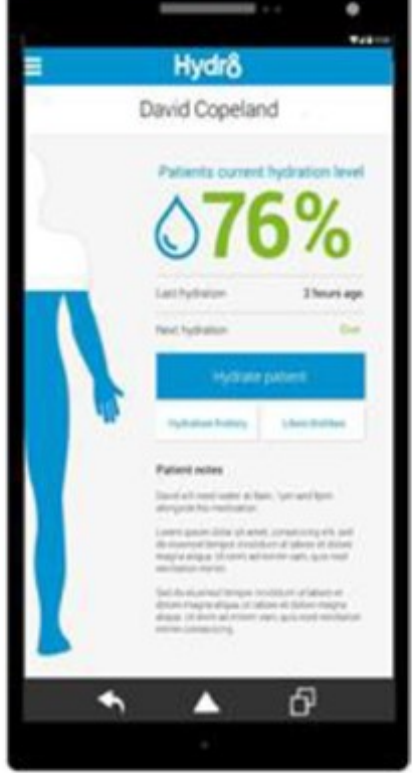
Figure 2. A screenshot from Hydr8 showing input screens. Source: "Hydr8" Brochure produced by Elaros, North Tyneside Clinical Commissioning Group and the Academic Health Science Network North East and North